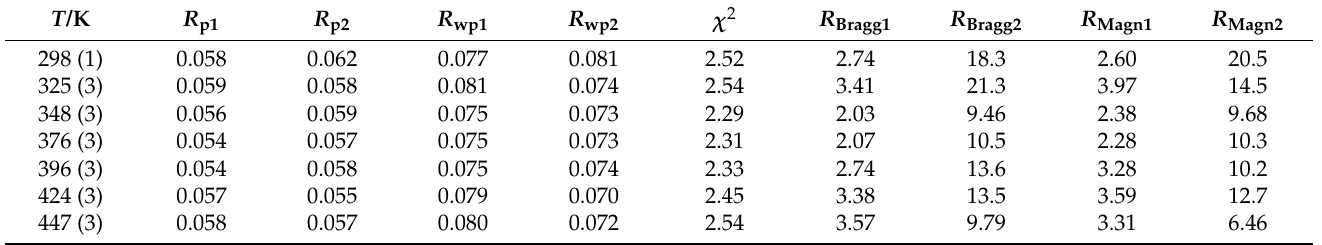
Table A9. Residual parameters of the Rietveld refinement of FePd 3 ( Pm 3 m ) based on in situ NPD data (see Figures 2–4 and Table A8) using FullProf